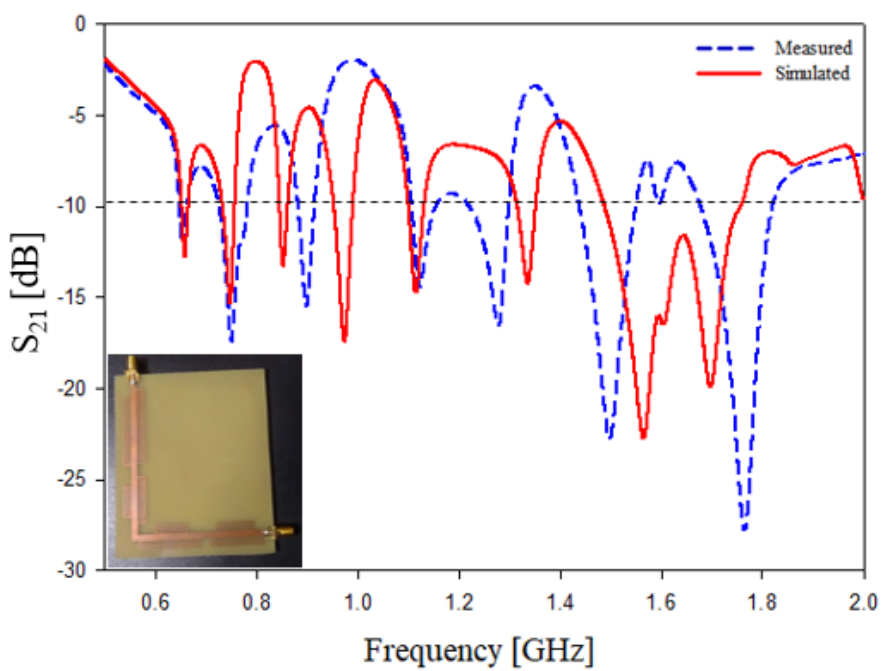
Figure 15. Frequency Response for 8 bit tag with code